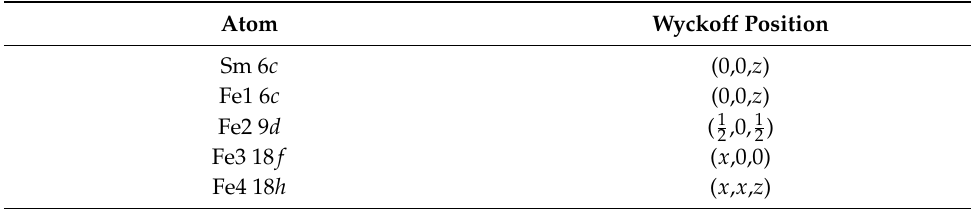
Table 2. Atom and Wyckoff positions for the R 2 Fe 17 R ¯3 m rhombohedral structure.